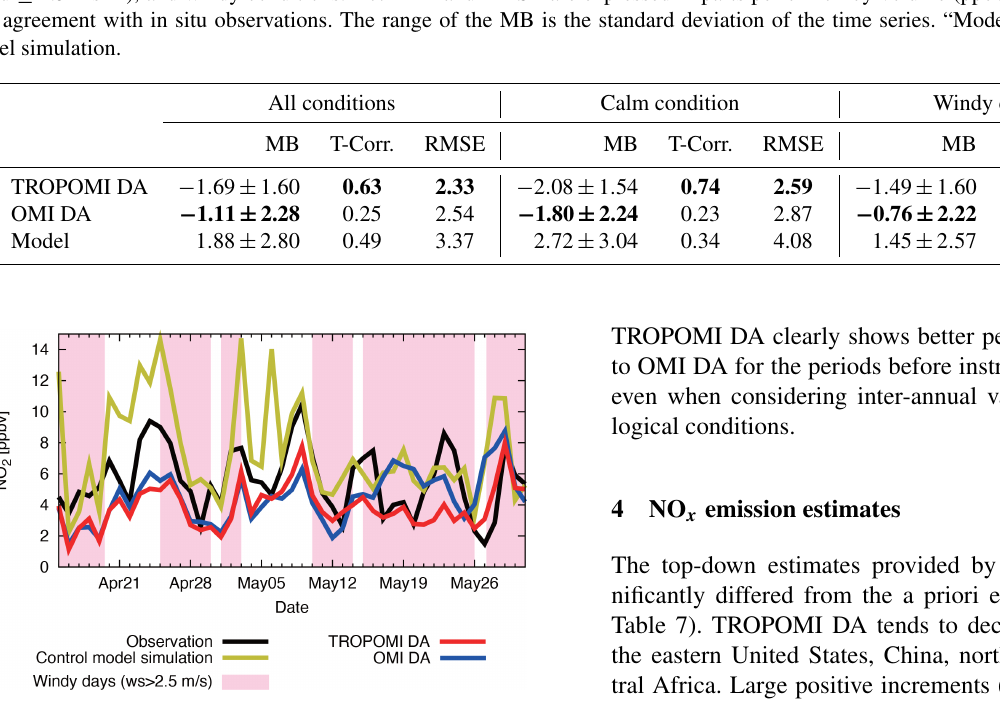
Figure 8. Surface NO 2 concentrations (ppbv) at 14:00LT over Los Angeles. The results were obtained from in situ observations (black), Tropospheric Monitoring Instrument (TROPOMI) data as- similation (DA) (red), Ozone Monitoring Instrument (OMI) DA (blue), and the control model simulation (yellow). The periods filled in pink are windy conditions (wind speed > 2 . 5ms − 1